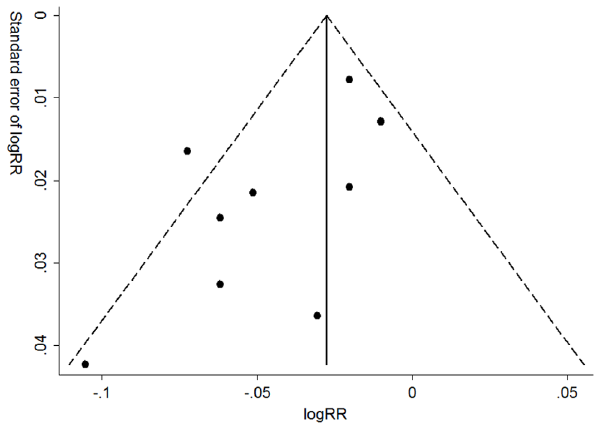
Figure 5. Publication bias in the studies.